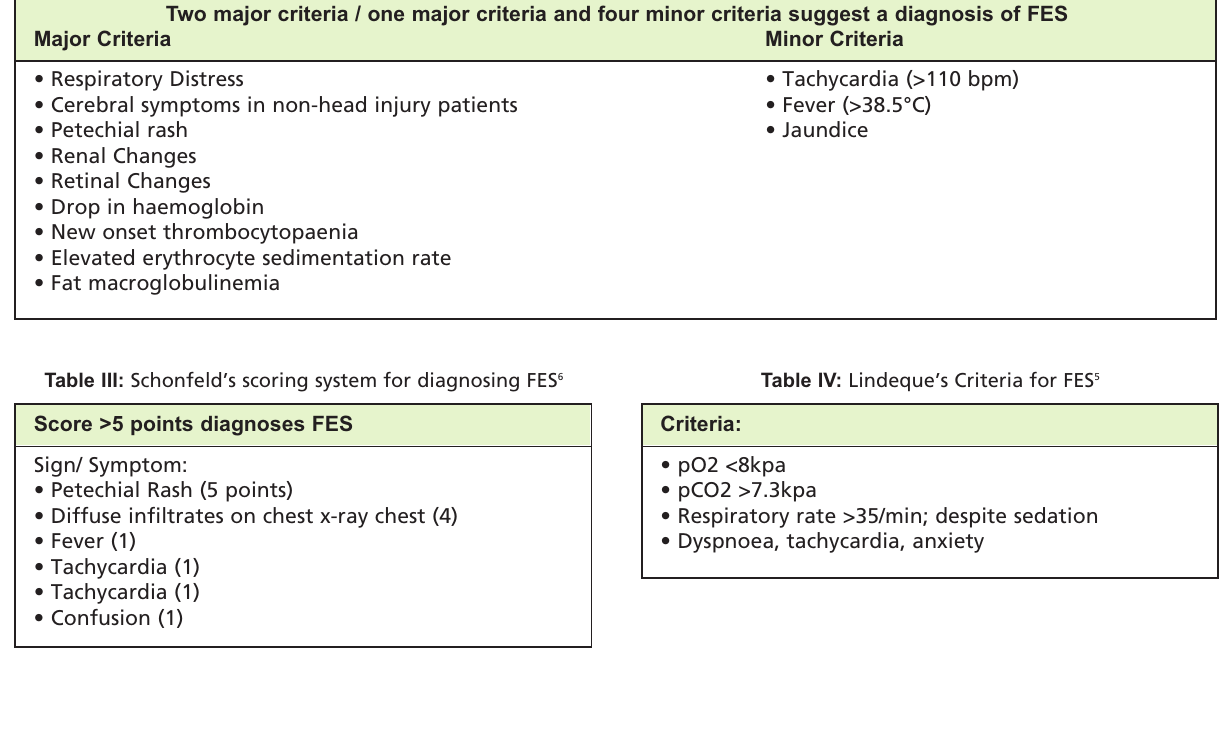
Gurd and Wilson Criteria for FES 3 Table II: